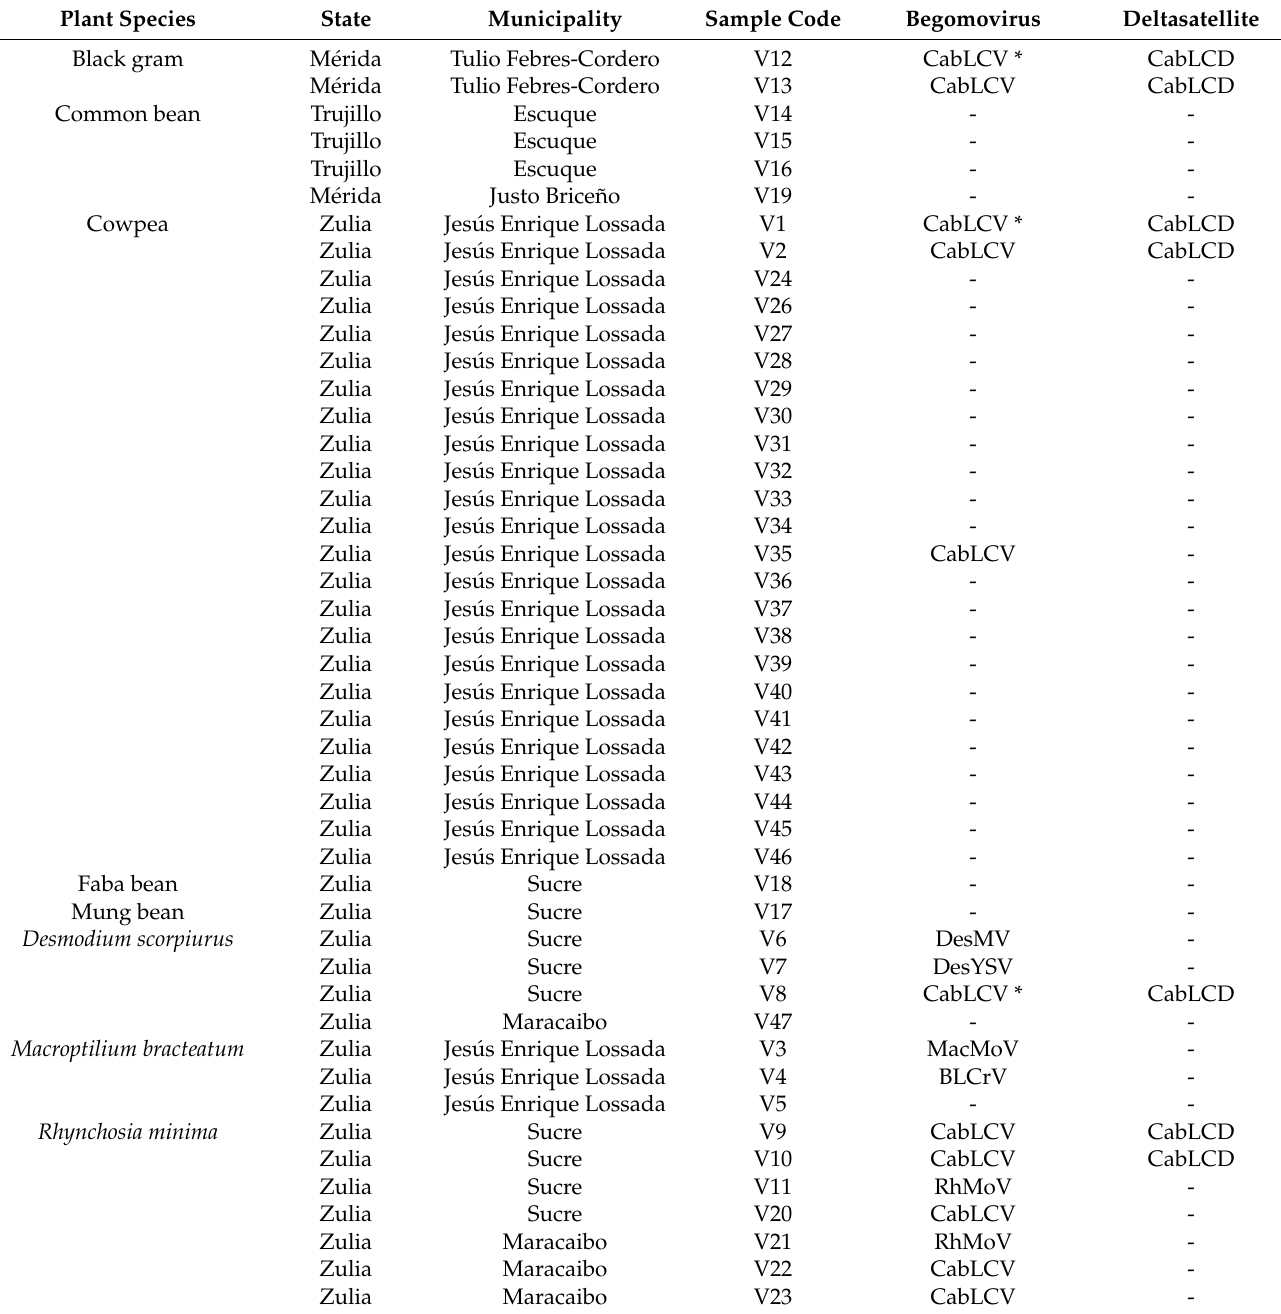
Table 1. Plant host, place of collection, and begomovirus/deltasatellite content of the samples analyzed in this study. Plant